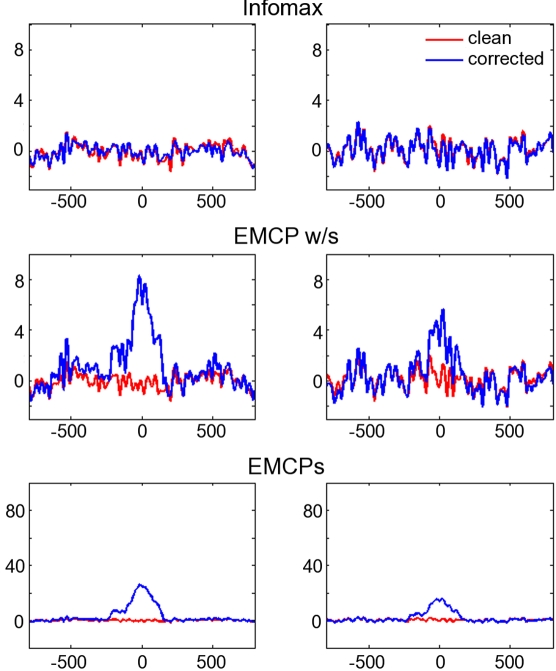
Propagation model with randomly varying blink amplitude.Averages time-locked to the maximum blink excursion (x-axis: time (ms); y-axis: µV). Only two channels are plotted (left and right column respectively). Red lines: clean, uncontaminated data; Blue lines: corrected data. Note the difference in the scaling for the EMCPs-corrected data. Also note that the channels for the propagation model have been chosen randomly, as well as the propagation factors used for simulation of blinks. Hence the real names (like “FCz”) are not informative, since they don't have spatial information anymore.